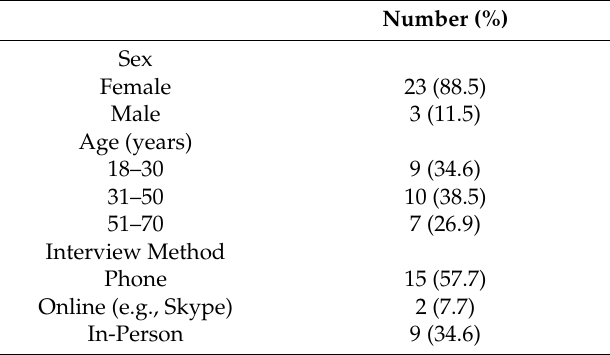
Table 1. Participant demographics and interview